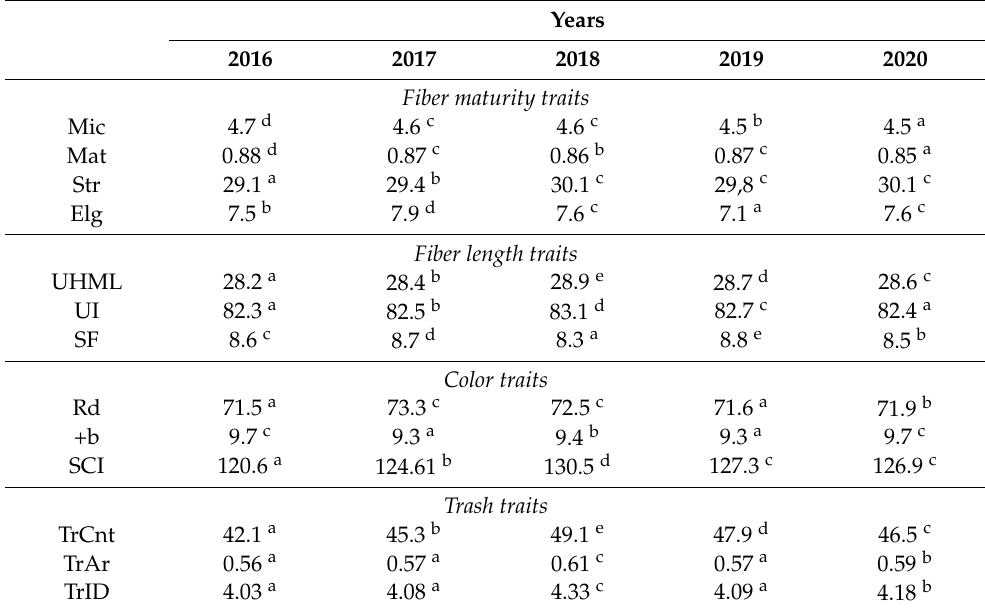
Table 5. Values in each testing year averaged across four environments in quality attributes of